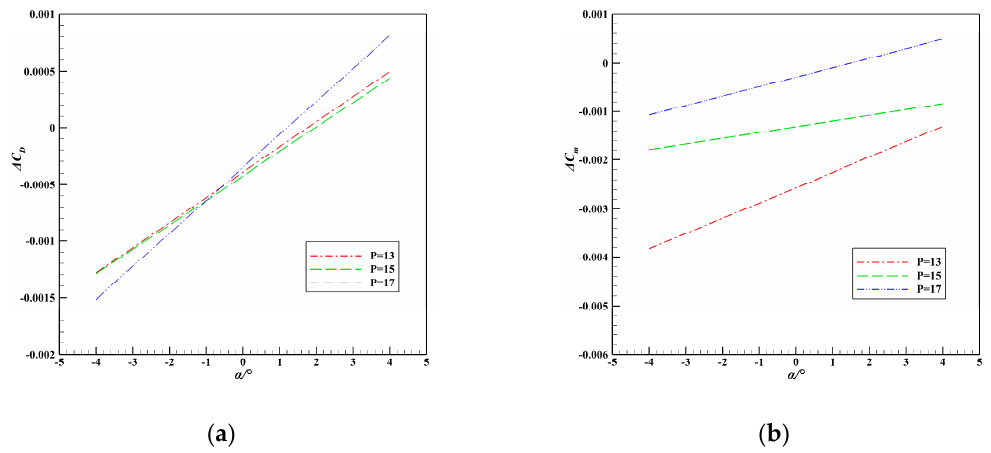
Figure 16. Support interference test results of the BWB aircraft with different inflection angles (P = 13 ◦ / 15 ◦ / 17 ◦ , Ma = 0.75): ( a ) ∆ C D - α curves; ( b ) ∆ C m - α curves.